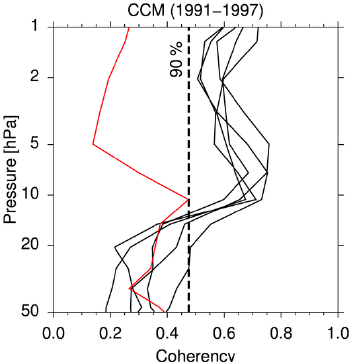
Figure 5. Vertical profile of the mean squared coherence between ozone and F205 averaged between 22- and 30-day periods and cal- culated for the time period 1991–1997. The black lines correspond to the results of individual ensemble members (five in total) and the red line to the results of the experiment forced with constant so- lar forcing. The vertical dashed line indicates the 90% confidence